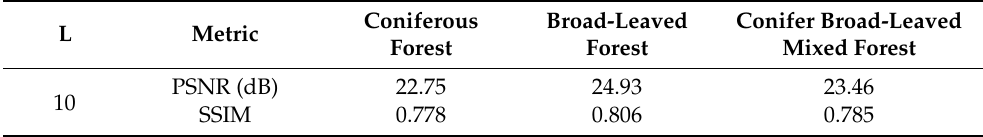
Table 7. The experimental results on three kinds of image